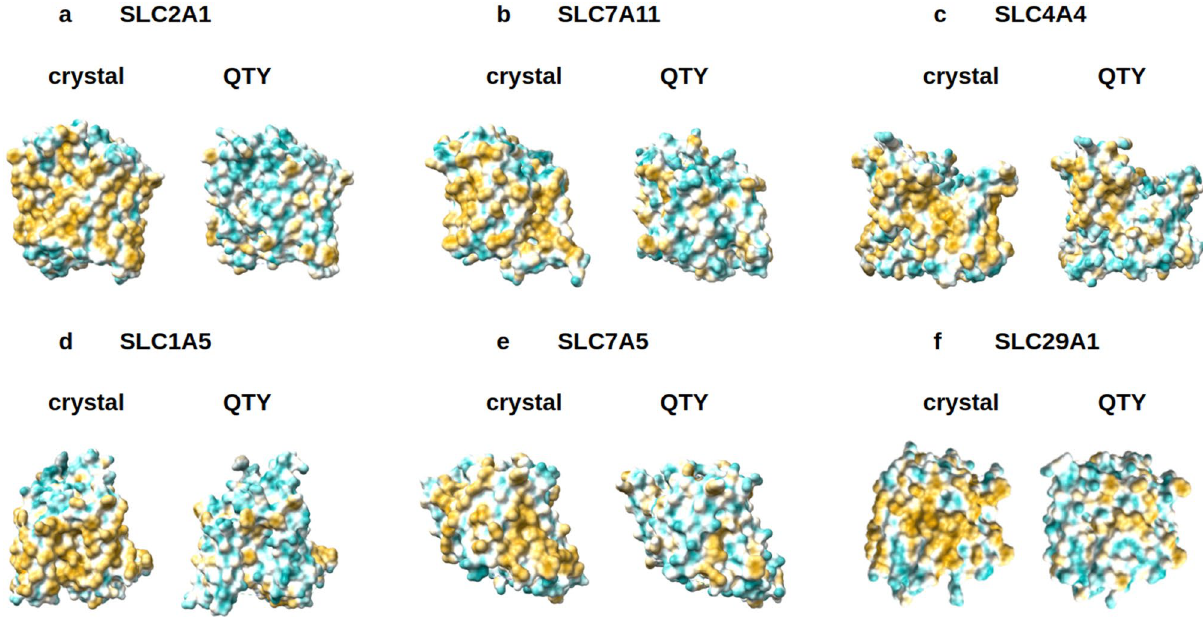
Figure 5. Hydrophobic surface of 6 crystal structures of solute carrier transporters and the designed QTY variants. The native solute carrier transporters have many hydrophobic residues L, I, V and F in the transmembrane helices. After Q, T, and Y replacement of the L, I, V, F, the surfaces are much more hydrophilic. The hydrophobic surface (brownish) of the native transporters become more cyan color: ( a ) SLC2A1 versus SLC2A1 QTY , ( b ) SLC7A11 versus SLC7A11 QTY , ( c ) SLC4A4 versus SLC4A4 QTY , ( d ) SLC1A5 versus SLC1A5 QTY , ( e ) SLC7A5 versus SLC7A5 QTY , ( f ) SLC29A1 versus SLC29A1 QTY . The hydrophobic surface is largely